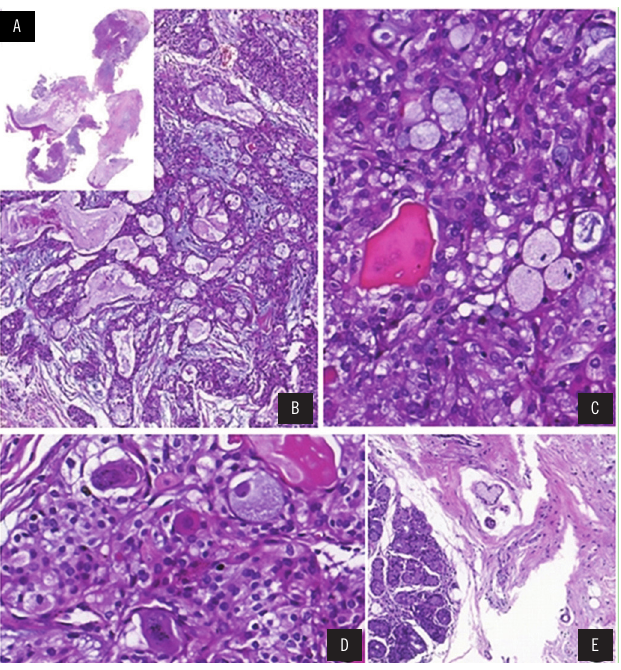
At histopathologic examination, a lesion characterized by proliferation of epidermoid, intermediate and mucous cells was observed, surrounded by a stroma of fibrous connective tissue of varying density. Those cells were arranged in some regions, sometimes in a solid pattern, sometimes forming cystic structures of variable size, with the presence of an amorphous eosinophilic material compatible with mucus inside them, besides the formation of mucin pools. Cellular atypia was not seen; just some neoplastic cells with slight pleomorphism and hyperchromatism ( Figure 3